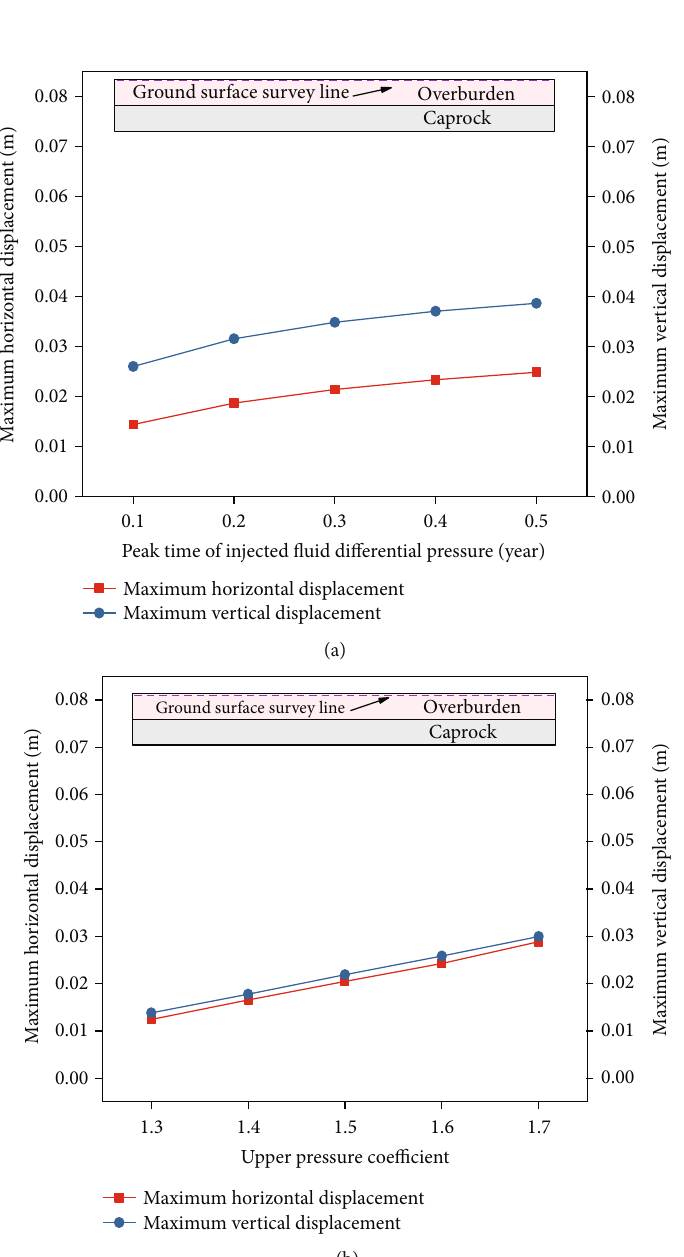
Figure 18: The variation curve of maximum ground surface deformation with di ff erent input parameters. (a) Injection rate pressure. (b) Upper limit pressure coe ffi cient.